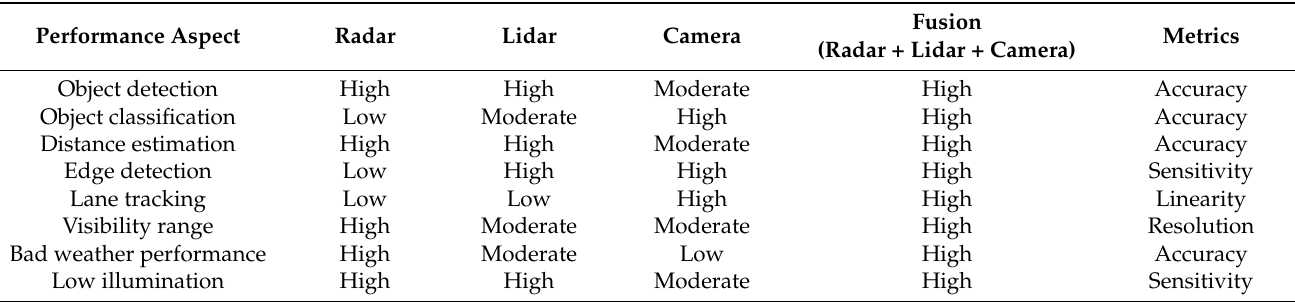
Table 1. Summary of the performance aspect at each automotive sensor (radar, lidar and camera) by highlighting their pros and cons in different tasks. An adapted version based on